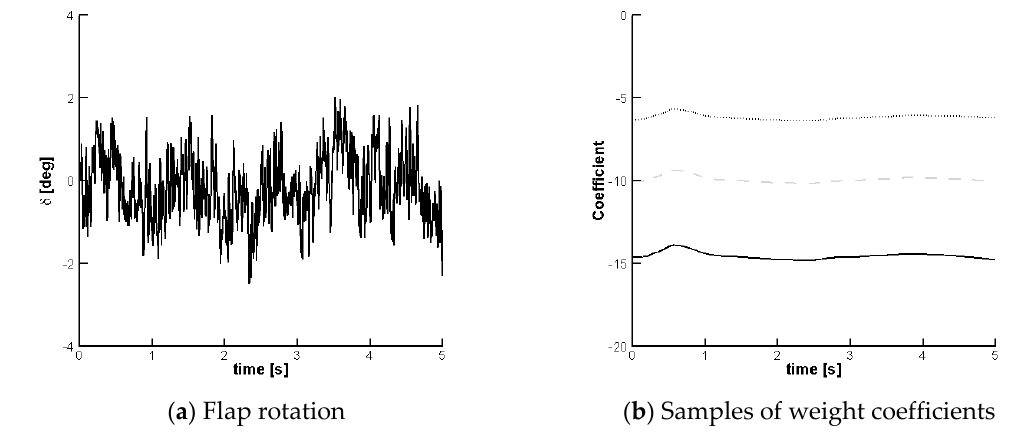
Figure 14. Aeroelastic response with control corresponding to Figure 13: ( a ) Commanded rotation of the trailing-edge flap; ( b ) Three samples (out of 20) of the weight coefficients of the controller.